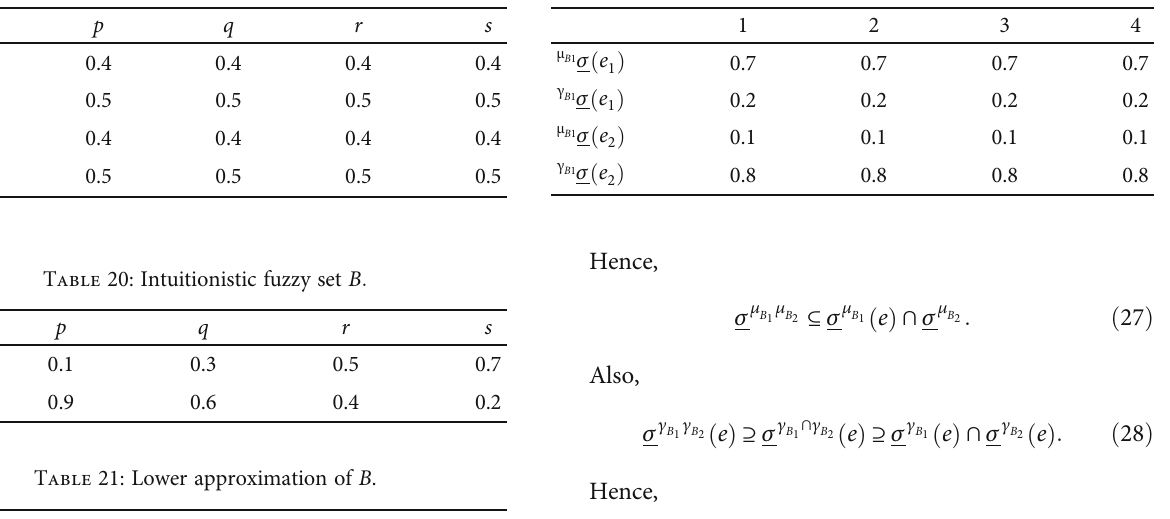
Table 19: Lower approximation of B